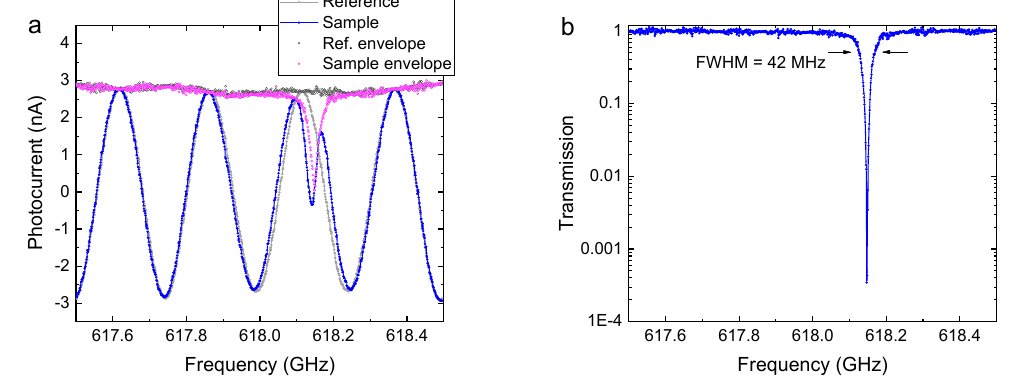
Figure 3. ( a ) Frequency-domain signals of a reference (grey) and sample (red) scans. The coherent detection scheme gives rise to phase “fringes”, which appear as an oscillating pattern when the THz frequency is varied. A Hilbert transform yields the envelope spectra of reference (black) and sample (pink). ( b ) The sample transmission spectrum (the square of the ratio of the sample and reference envelope data) reveals the whispering-gallery-mode resonance with an FWHM linewidth of 42 MHz. Courtesy of Dominik Vogt, University of Auckland, New Zealand.